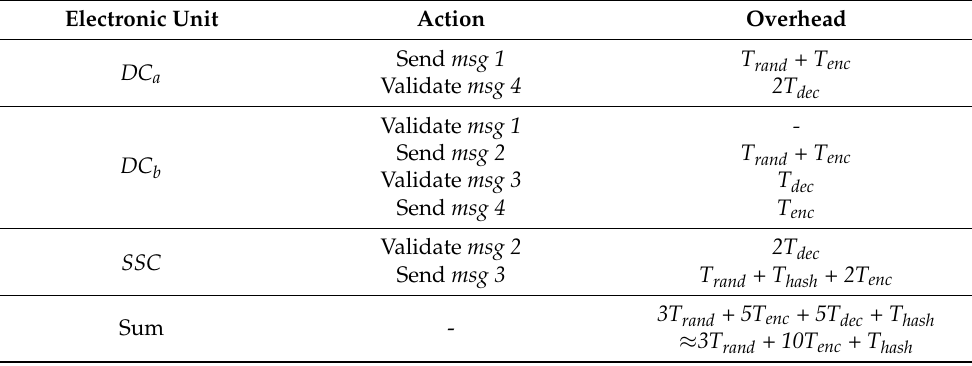
Table 4. Calculation overhead of the authentication